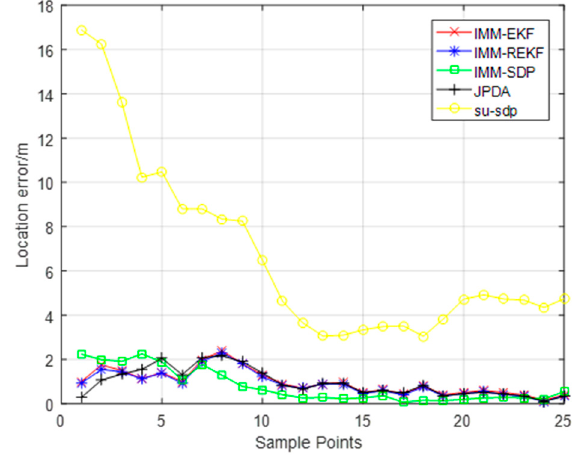
Figure 12. The localization error at each sampling point.